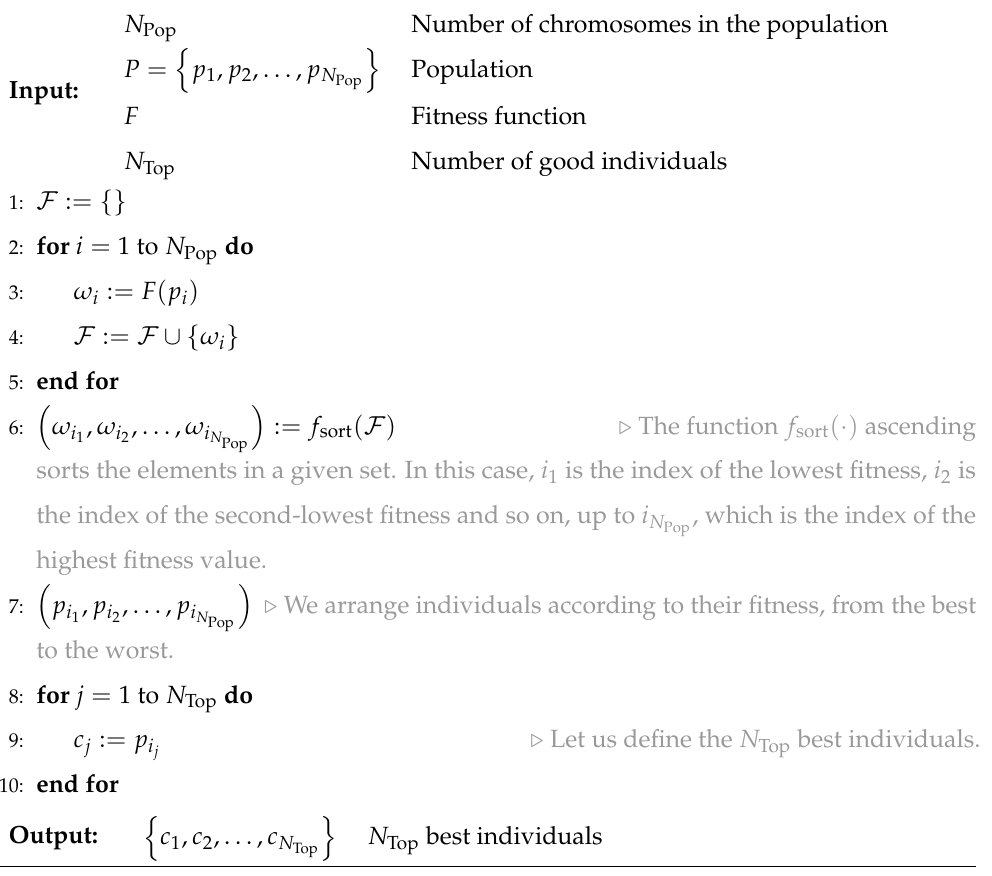
Algorithm 1 Defining the N Top best individuals